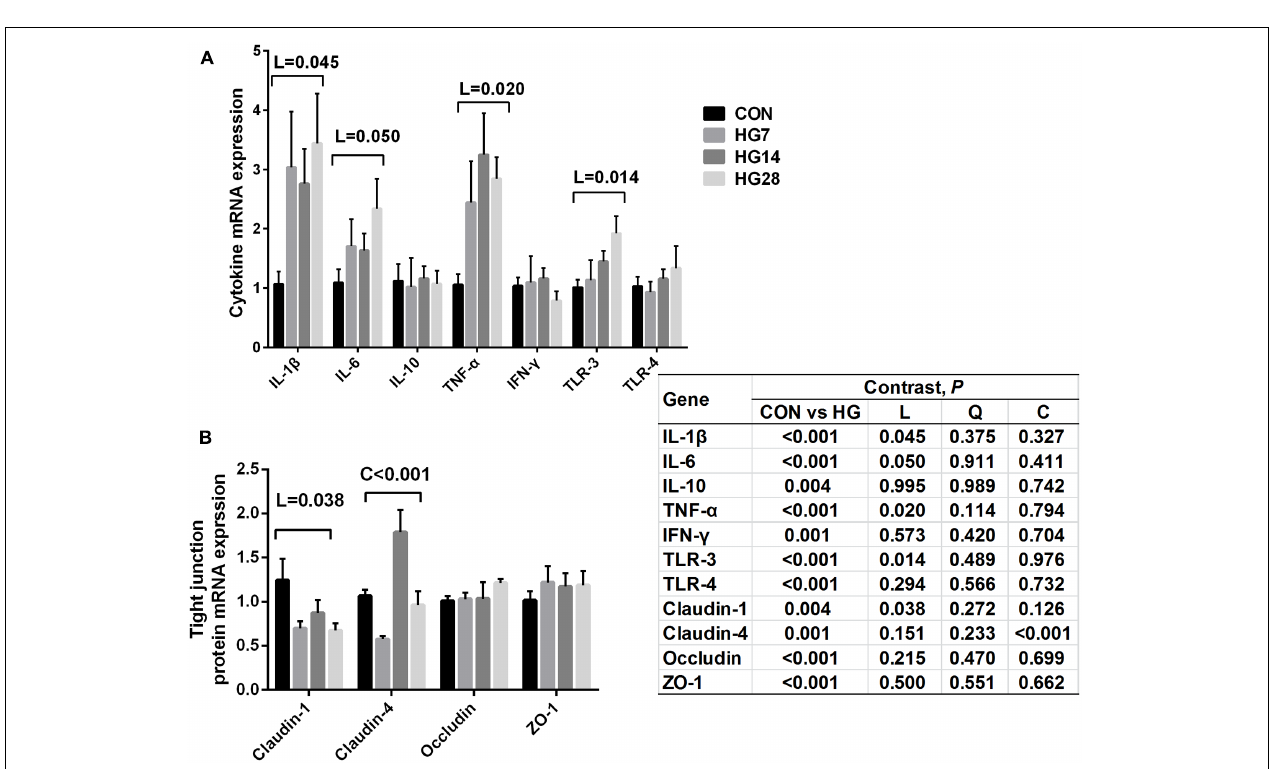
FIGURE 4 | Effects of feeding a high grain (HG) diet on the relative mRNA expression of cytokines (A) and tight junction protein genes (B) in the colon of sheep. The amount of GAPDH mRNA levels was used to normalize the relative amount of each gene.